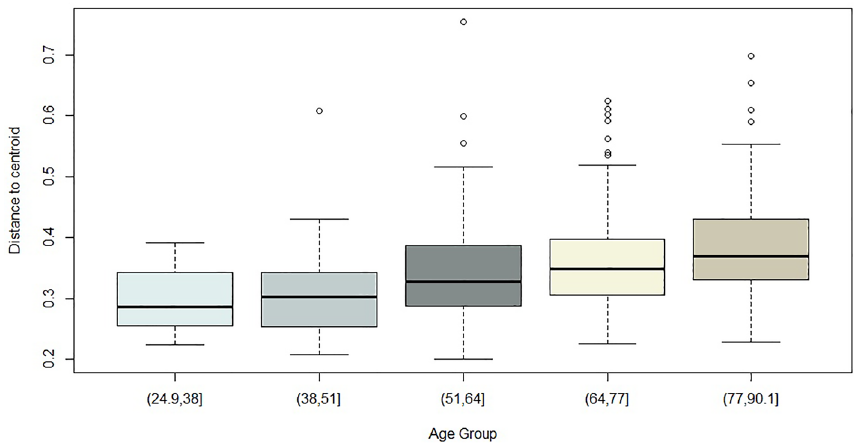
Figure 3. Bray Curtis beta dispersion of age within full cohort sample. A difference in the variance across age groups was demonstrated ( P = 5.125e−06, ANOVA).